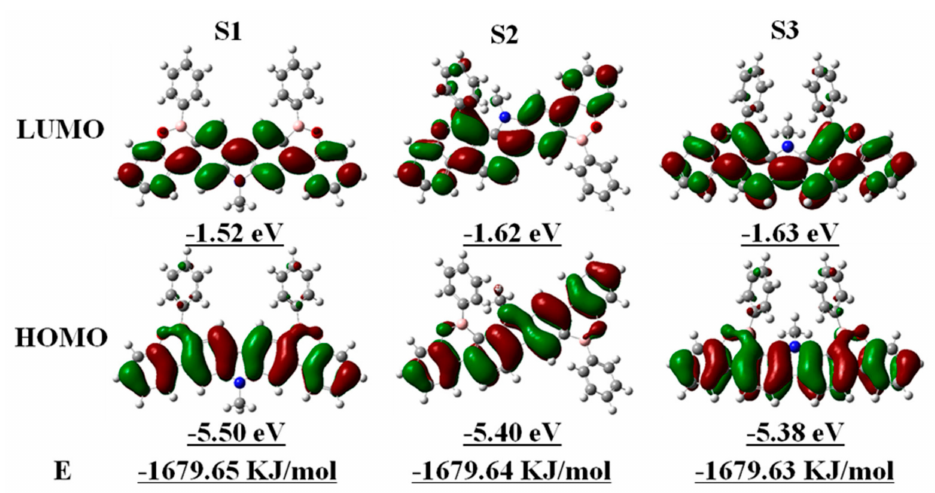
Figure 1. Optimal structure and total energy of compounds S1, S2, and S3 based on B3LYP / 6-31G(d) level by Gaussian